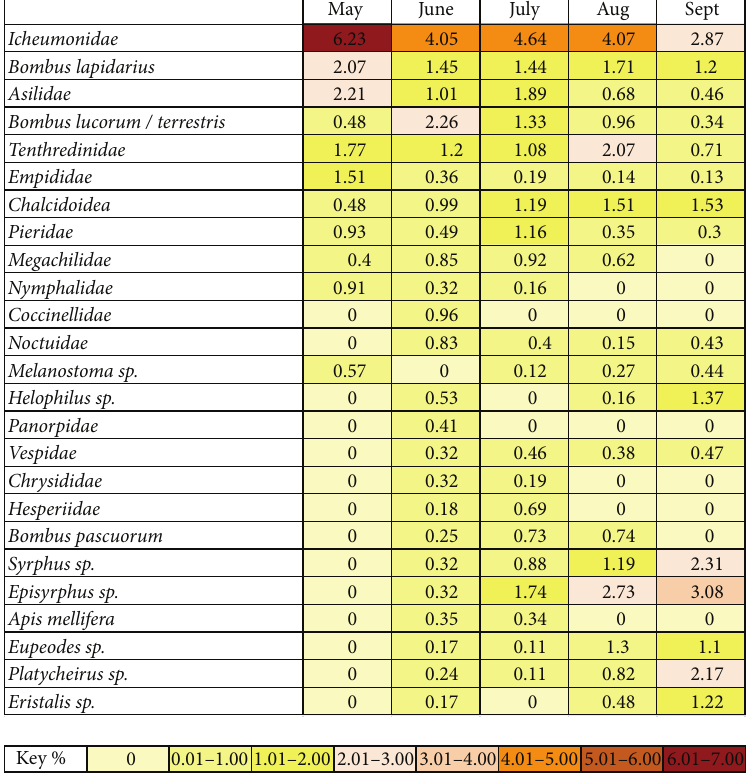
Figure 10: Heatmap-table summarising the relative abundance (%) of dominant taxon for each month, based on SIMPER analysis of count data recorded during the survey